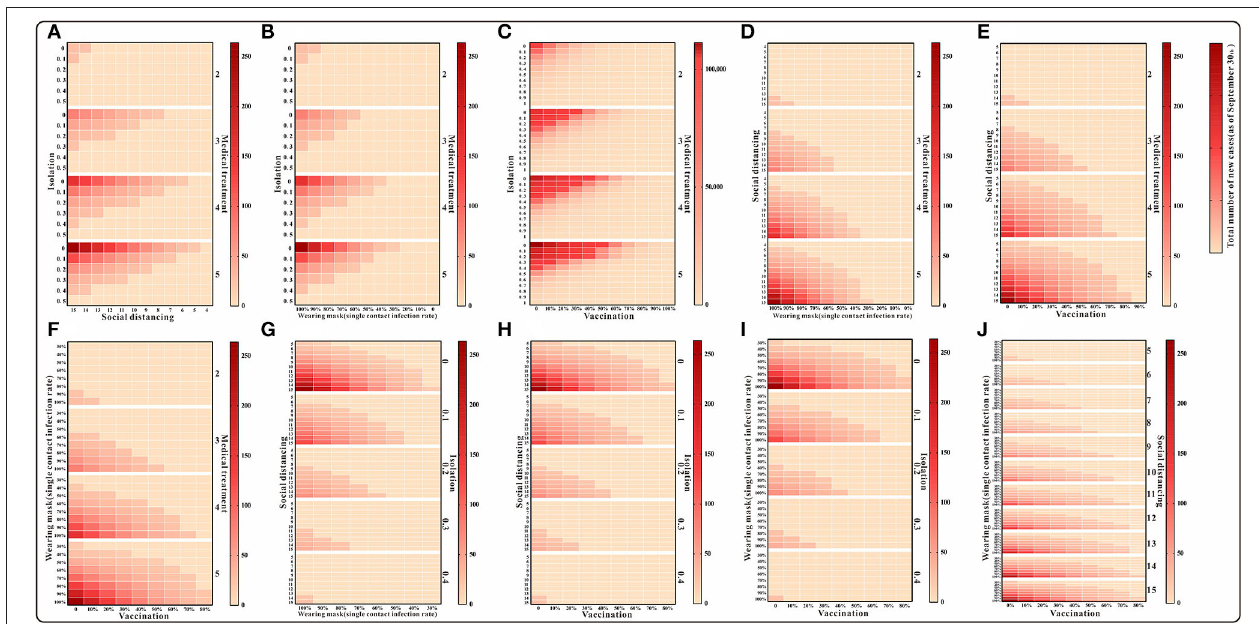
FIGURE 6 | The simulation results of a mix of three interventions in Xiamen City, China, 2021. (A) Medical treatment and isolation and social distancing; (B) medical treatment and isolation and wearing mask; (C) medical treatment and isolation and vaccination; (D) medical treatment and social distancing and wearing mask; (E) medical treatment and social distancing and vaccination; (F) medical treatment and waring mask and vaccination; (G) social distancing and isolation and wearing mask; (H) social distancing and isolation and vaccination; (I) isolation and wearing mask and vaccination; and (J) social distancing and wearing mask and